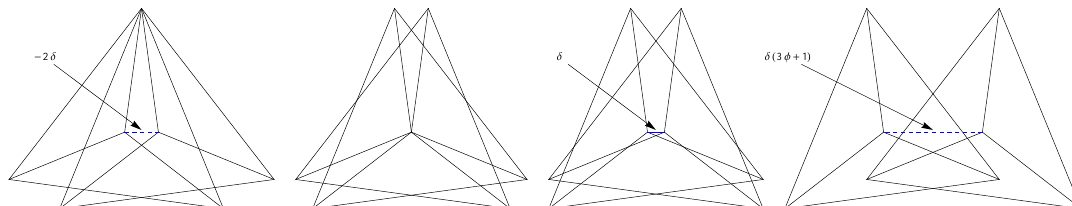
Figure 7. Side-by-side comparison of face junctions. All face junctions may be obtained by translation of the (projected) tetrahedra of the 3- and 5-BC helix (pictured center left) by integer- and golden-ratio-based multiples of δ = displacement between tetrahedra of a face junction for 5 tetrahedra about a common edge (pictured center right). From left to right, the displacements between the tetrahedra are − 2 δ , 0, δ , and ( 3 φ + 1 ) δ